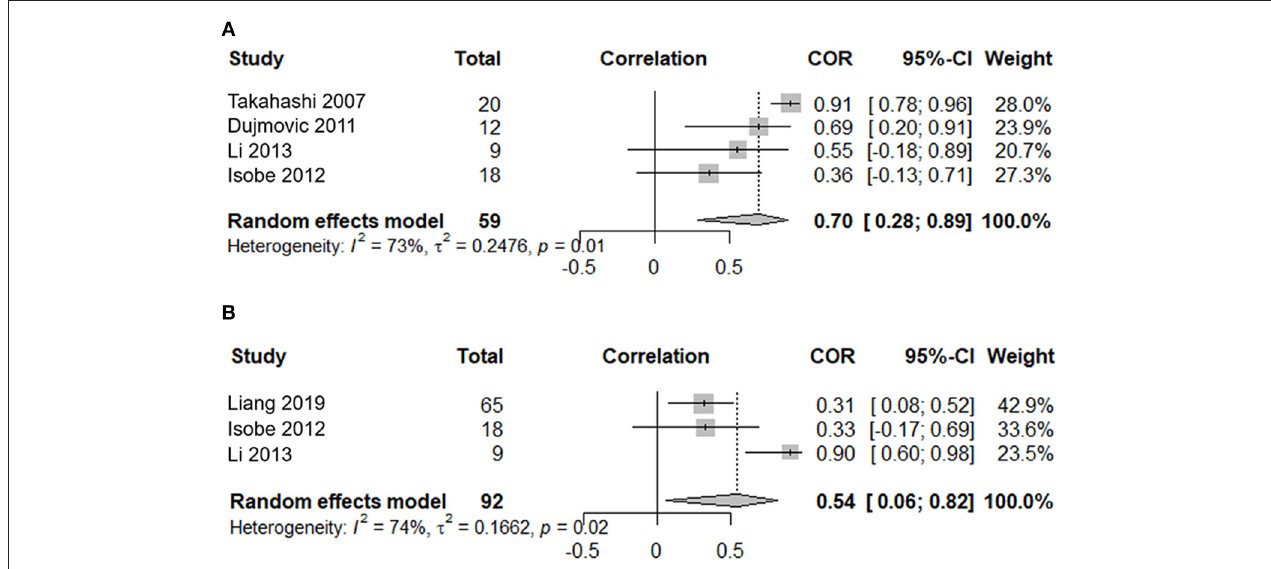
FIGURE 4 | Correlation meta-analysis between the serum AQP4-IgG titer and clinical parameters in the attack phase for patients with NMOSD. (A) Correlation meta-analysis between the serum AQP4-IgG titer and the number of involved spinal cord segments. (B) Correlation meta-analysis between the serum AQP4-IgG titer and the EDSS score. AQP4-IgG, aquaporin4-IgG; NMOSD, neuromyelitis optica spectrum disorder; COR, correlation coefficients; EDSS, expanded disability status scale; 95% CI, 95% confidence